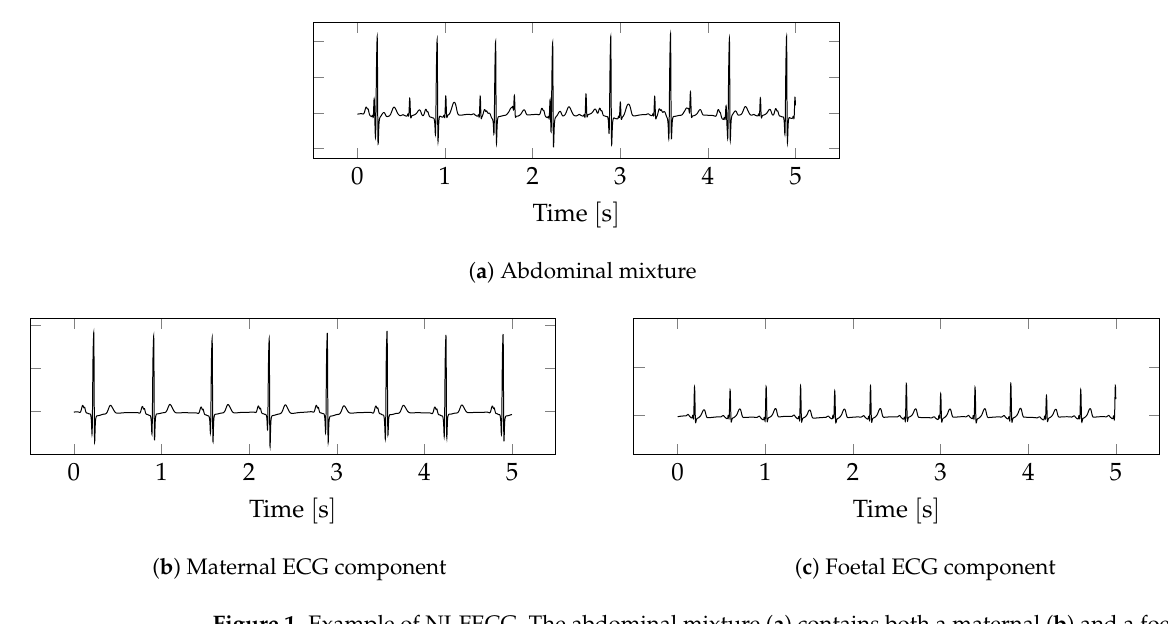
Figure 1. Example of NI-FECG. The abdominal mixture ( a ) contains both a maternal ( b ) and a foetal ( c ) component. The foetal component has a lower SNR than the maternal component. The figures depict an ideal case. In practice, the SNR is typically